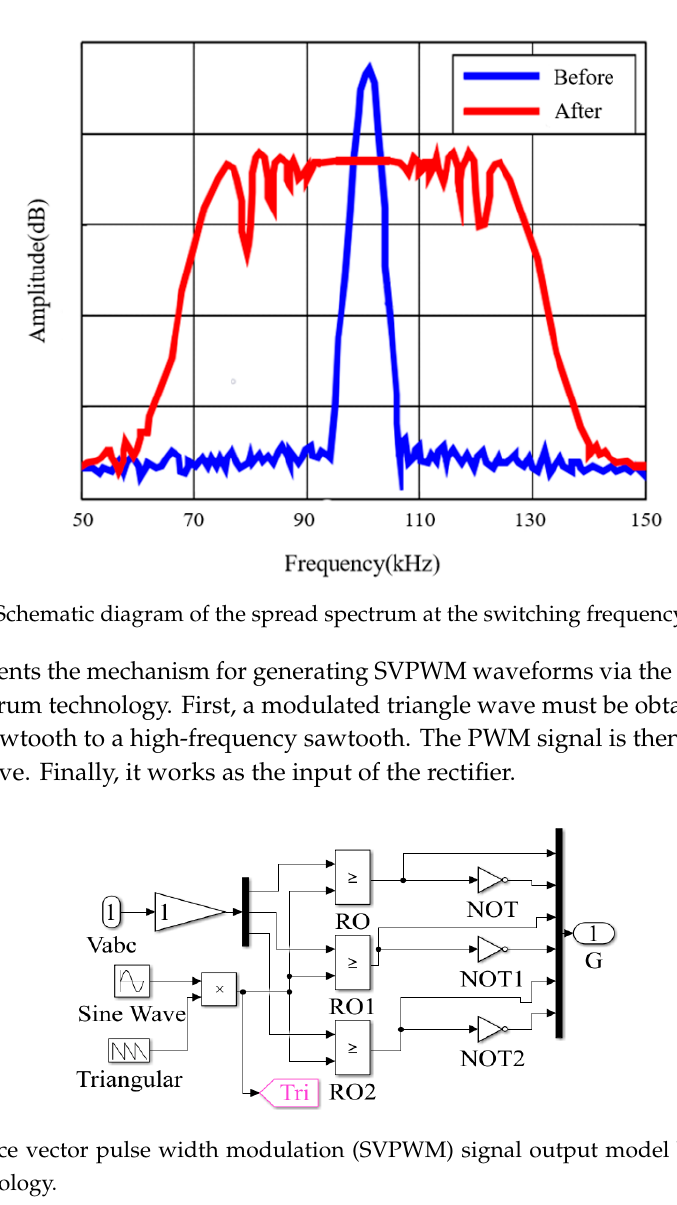
Figure 22. Space vector pulse width modulation (SVPWM) signal output model based on spread spectrum technology.